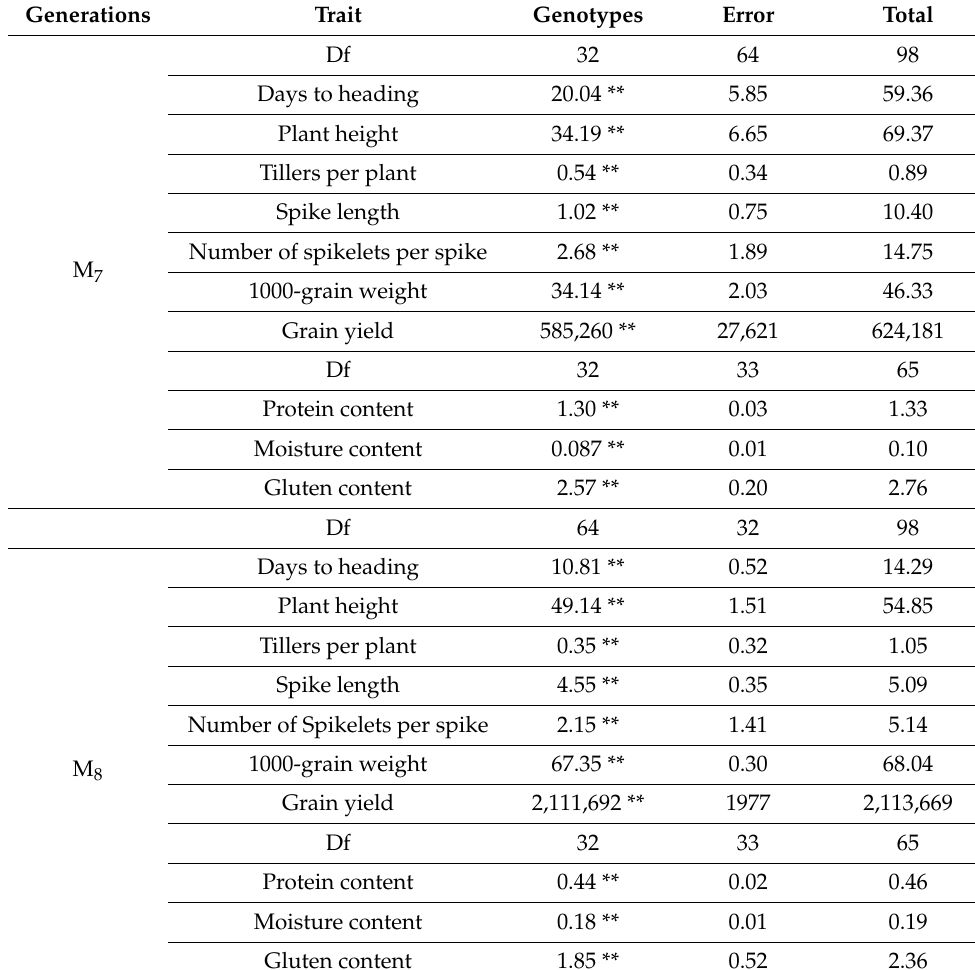
Table 2. Mean square values of all traits calculated for 32 mutant lines and the wild type in M 7 and M 8 generations at the NIAB